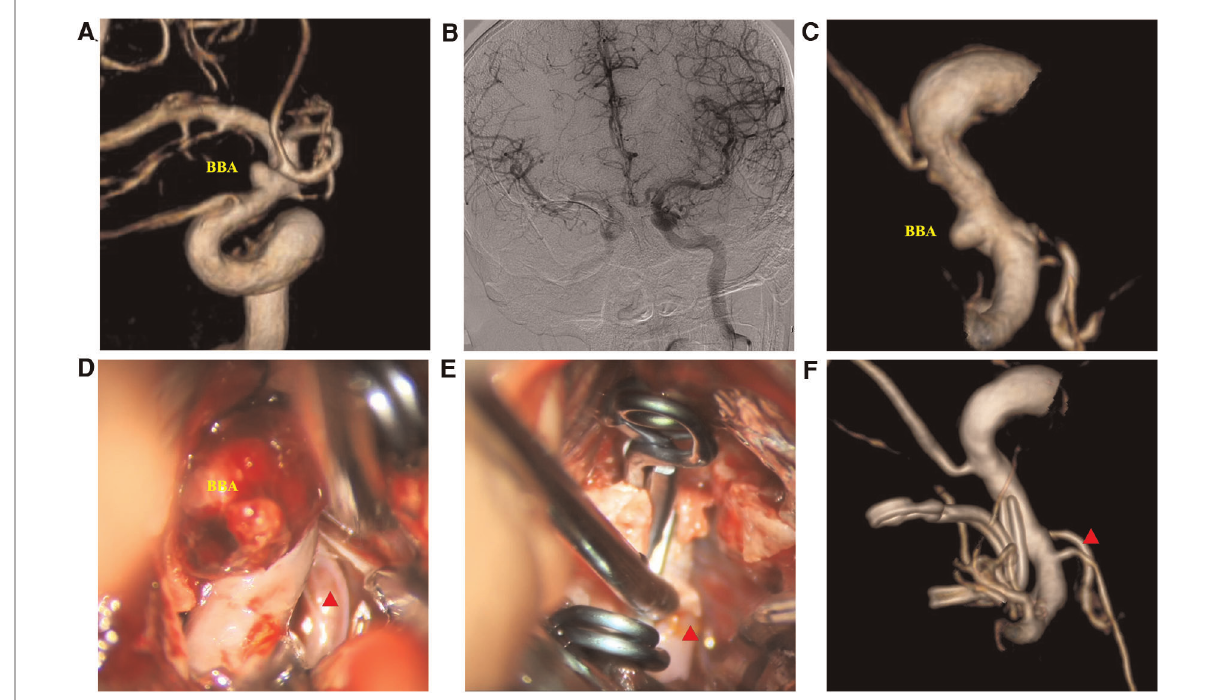
FIGURE 1 Clip-reinforced wrapping using the temporalis fascia technique for blood blister-like aneurysms. ( A ) Three-dimension digital subtraction angiography (3D-DSA) of the ICA. ( B ) Matas test revealing adequate compensation. ( C ) 3D-DSA images at the operation angle. ( D ) Microscopic view revealing the hematoma at the surface of the BBA. ( E ) Two permanent clips treating the aneurysm via the CRYST technique. ( F ) DSA images ten days postoperatively. Red triangle: posterior communicating